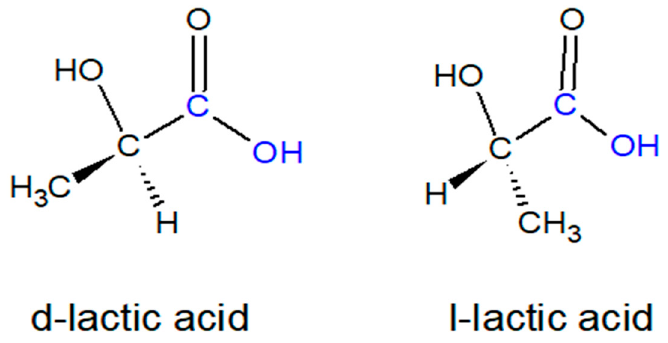
Figure 3. The lactic acid stereoisomers.